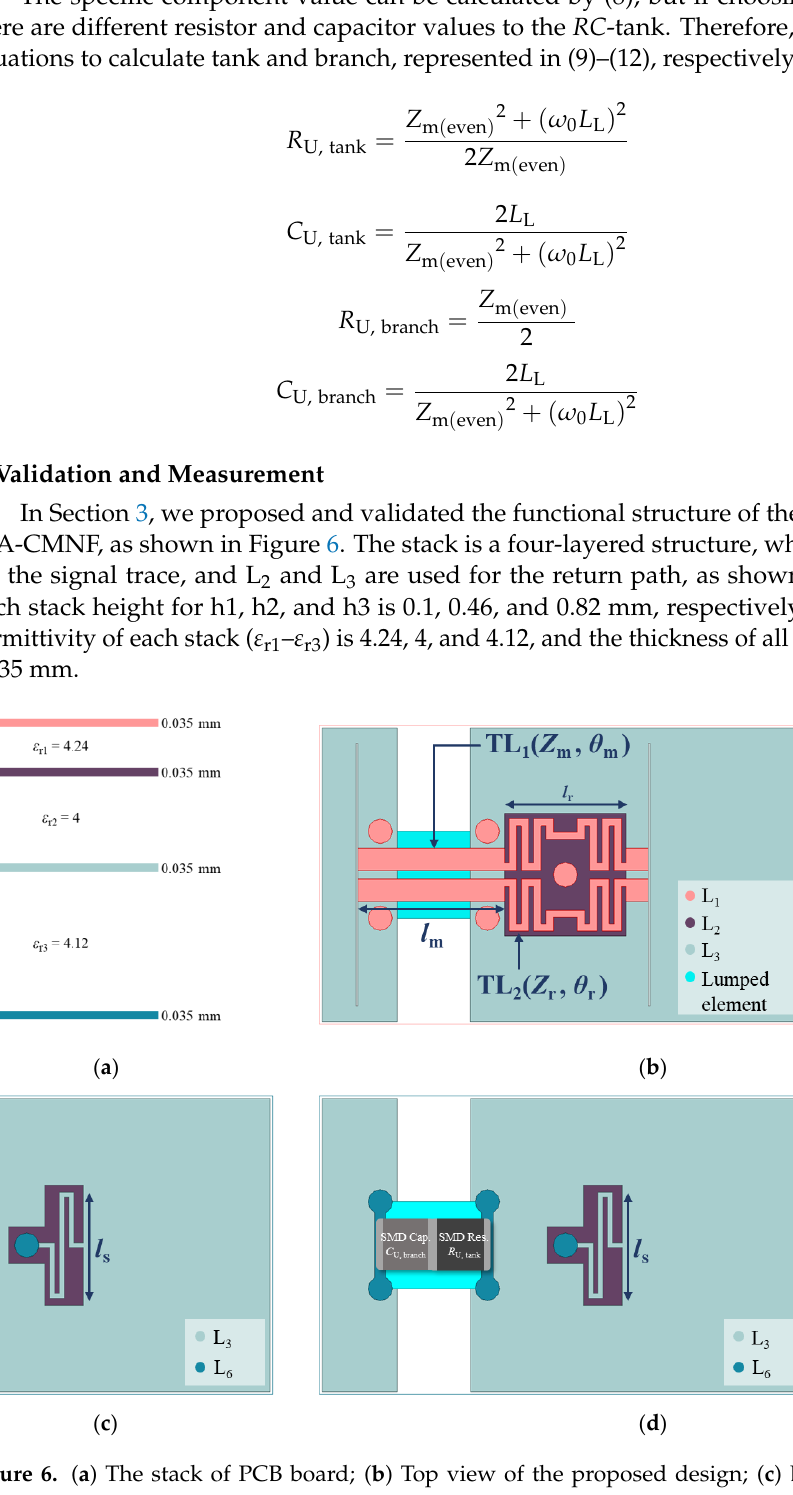
Table 2. Electrical and Physical Parameters. θ m